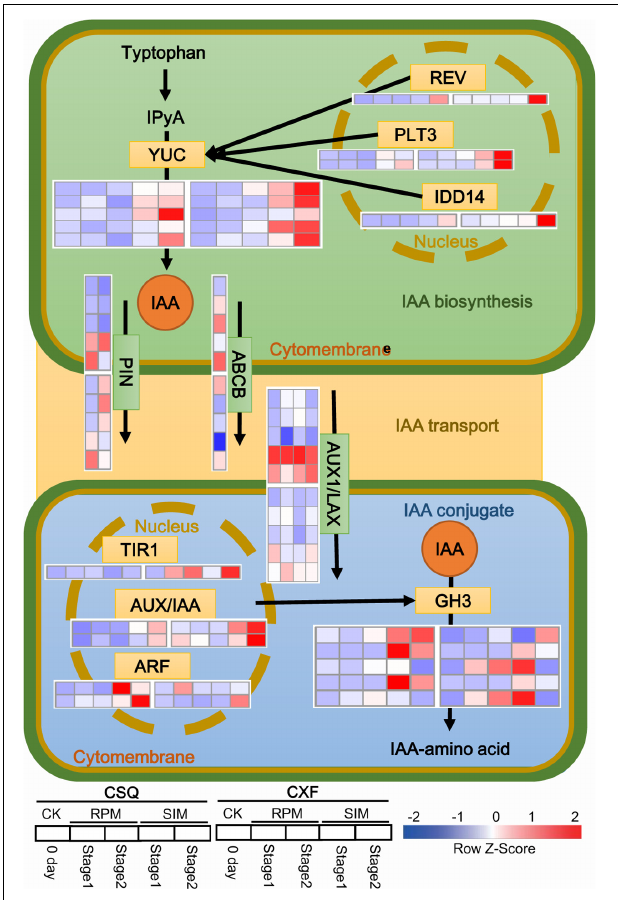
FIGURE 4 | Transcriptional changes in auxin-related genes. Red indicates upregulated genes and blue indicates downregulated genes. IAA, indole-3-acetic acid; IPyA, indole-3-pyruvic acid; YUC, YUCCA, indole-3-pyruvate monooxygenase; REV, homeobox-leucine zipper protein REVOLUTA; PLT3, AP2-like ethylene-responsive transcription factor PLETHORA3; IDD14, INDETERMINATE DOMAIN14 transcription factors; ABCB, ABC transporter B family member; PIN, auxin efflux carrier family PIN; AUX1/LAX, auxin influx carrier; TIR1, transport inhibitor response 1; ARF, auxin response factor; AUX/IAA, auxin-responsive protein IAA; GH3, auxin responsive Gretchen Hagen3 gene family.